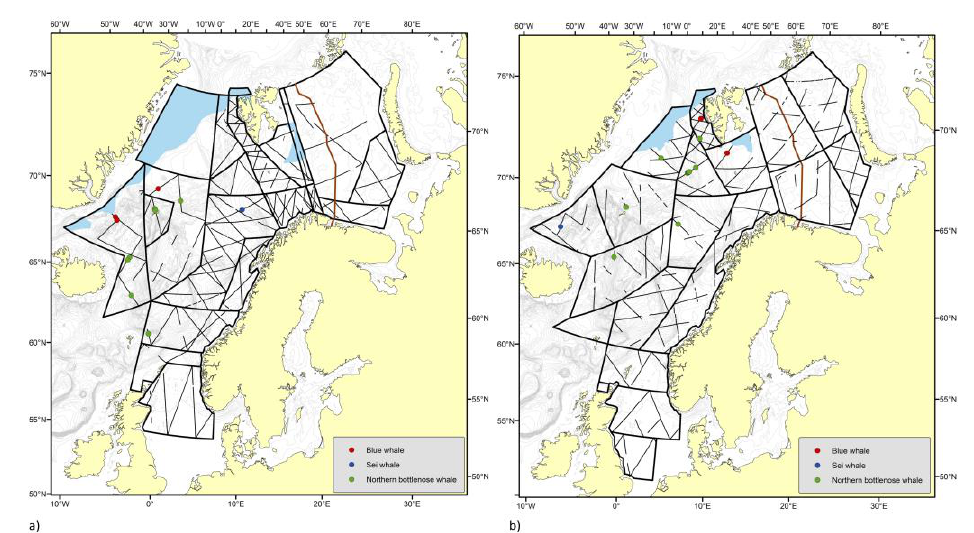
Figure 13. Distribution of blue whales, sei whales, and northern bottlenose whales sighted during (a) the 2002 – 2007 surveys and (b) the 2008 – 2013 surveys. The blue areas represent ice